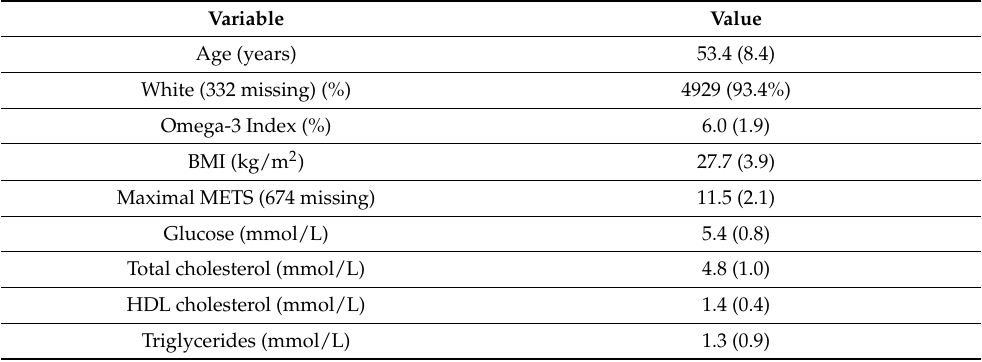
Table 1. Baseline characteristics of 5607 men. The Cooper Center Longitudinal Study (CCLS), 2007–2019 1